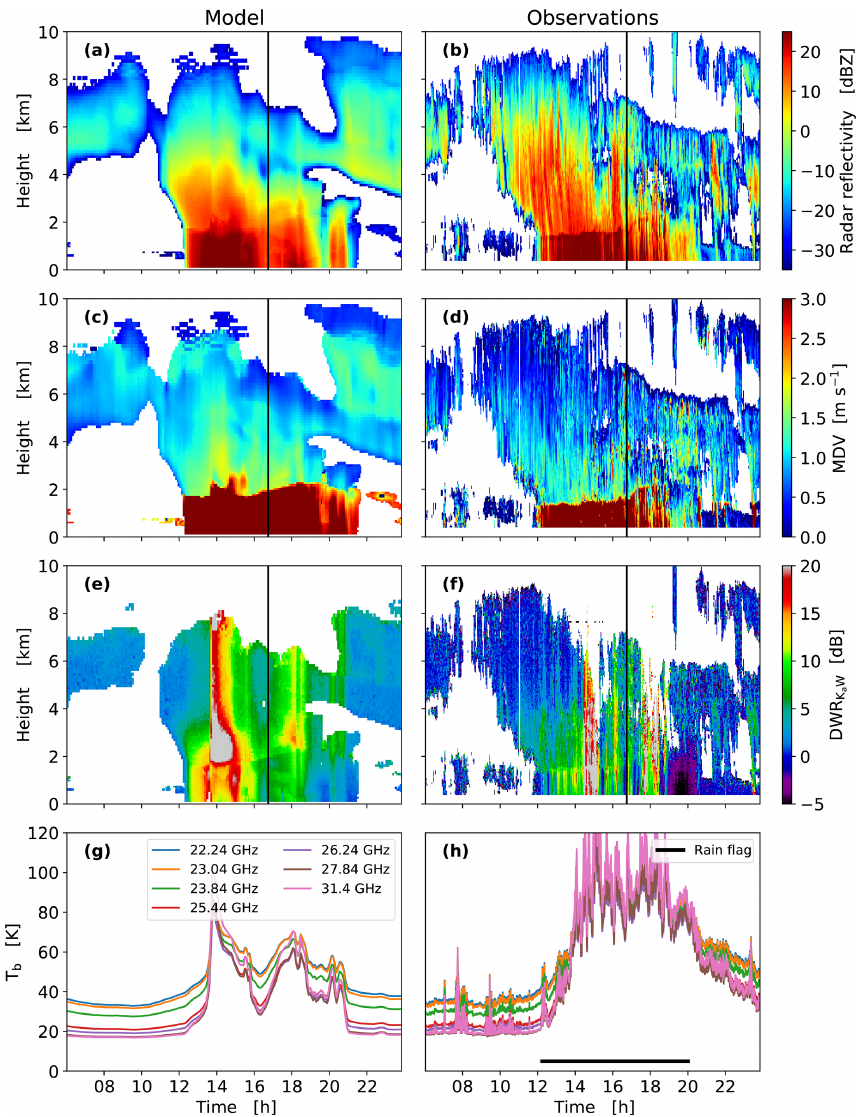
Figure 3. Case study of a cold front observed at the JOYCE site on 19 November 2015. From top to bottom: time versus height above ground, showing equivalent radar reflectivity factor Z e (dBZ) at the Ka band (a, b) , mean Doppler velocity MDV (ms − 1 ) (c, d) , dual-wavelength ratio DWR between the Ka and W band (dB) (e, f) , and T B (K) of the HATPRO microwave radiometer for the seven water vapor channels (g, h) . The right side shows the observations; PAMTRA simulations based on the ICON-LEM output are shown in the left column. The black horizontal bar in the HATPRO observation plots indicates periods of an active rain flag for the microwave radiometer; data during this period are likely to be disturbed by rain on the radome. The vertical black line in the radar time–height plots indicates the time used for the spectra comparison in Fig.